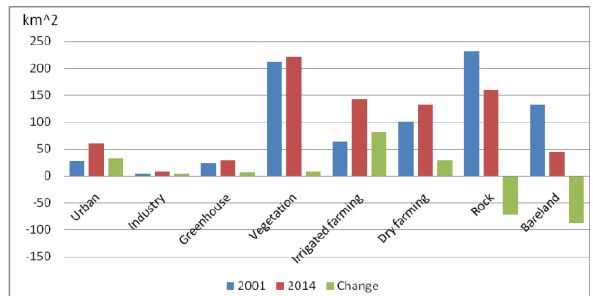
Figure 5. The amount of LU/LC changes between the years 2001-2014 (x and y axis shows LU/LC types and areas, respectively)